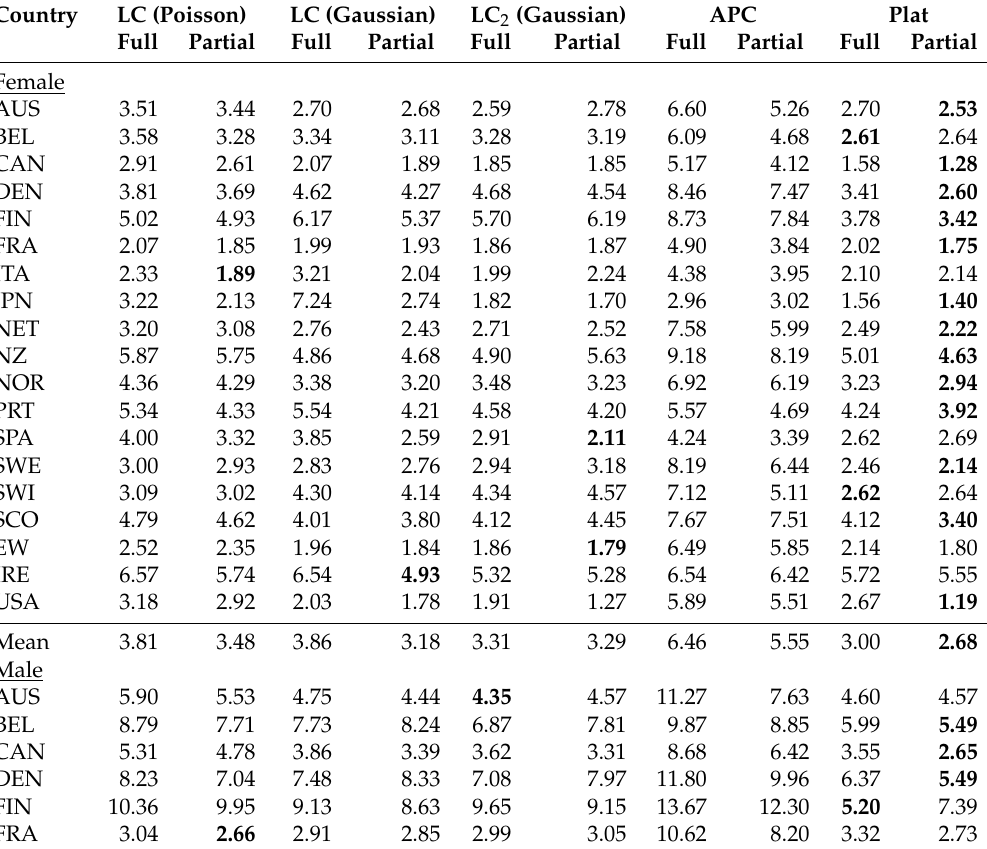
Table 3. For the one-step-ahead forecast horizon h = 1, we compute the mean interval score ( × 100) for each country and each